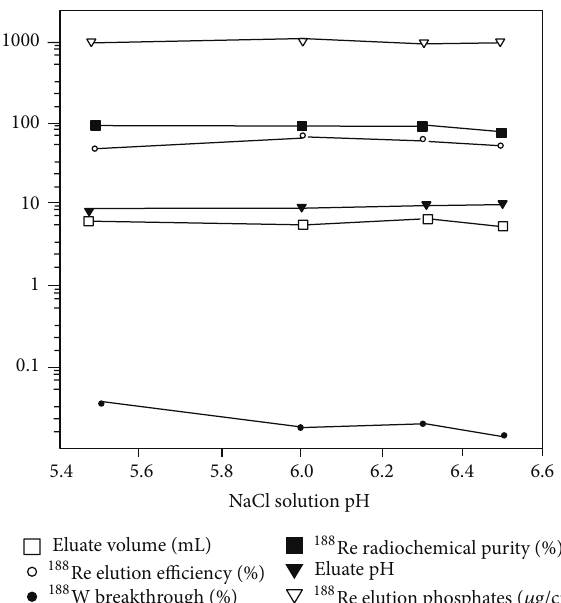
Figure 6: Performance of the hydroxyapatite based 188 W/ 188 Re generators as a function of the 0.9% NaCl solution pH (series A) [31].